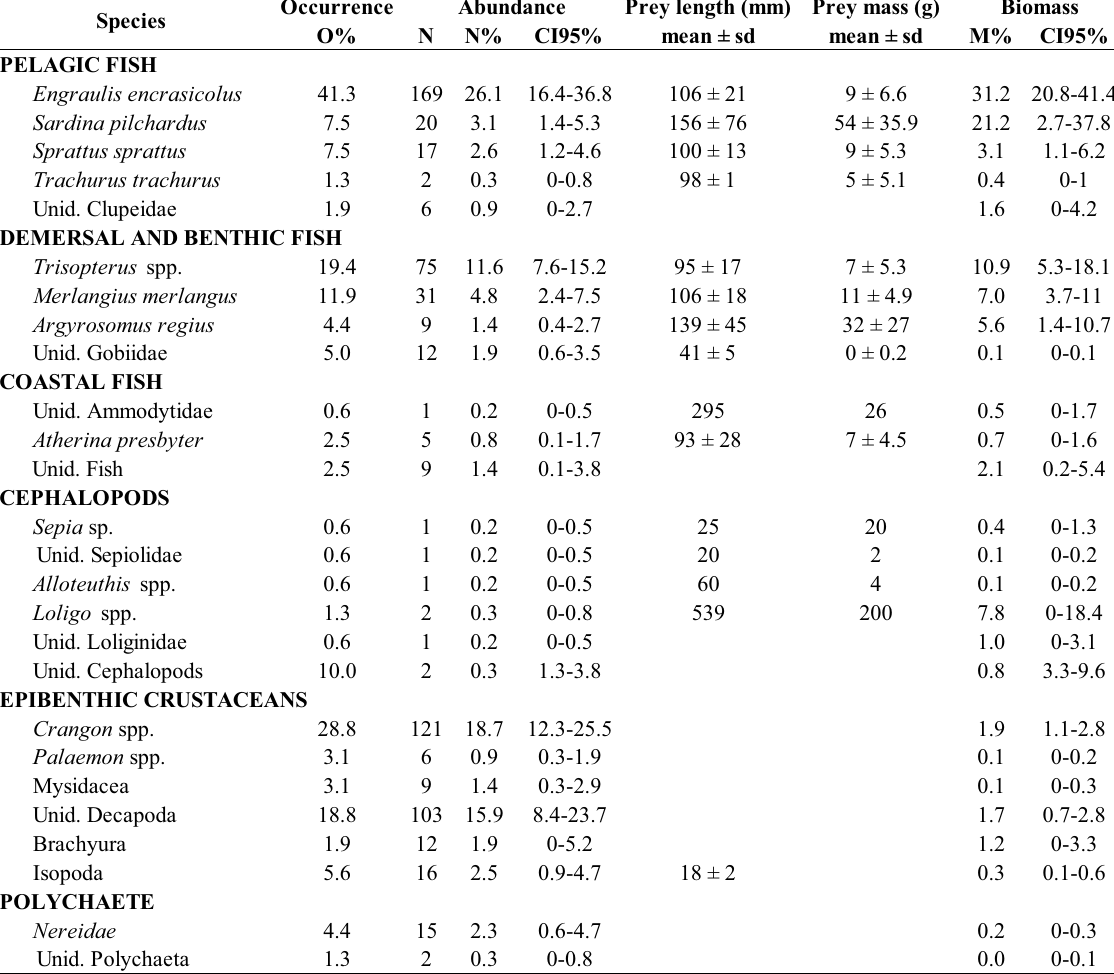
Table 2. Prey found in 163 non-empty stomach contents of Argyrosomus regius in Bay of Biscay. N: number of each prey, sd: standard deviation, CI95%: 95% con fi dence interval (CI), Unid.: unidenti fi ed.